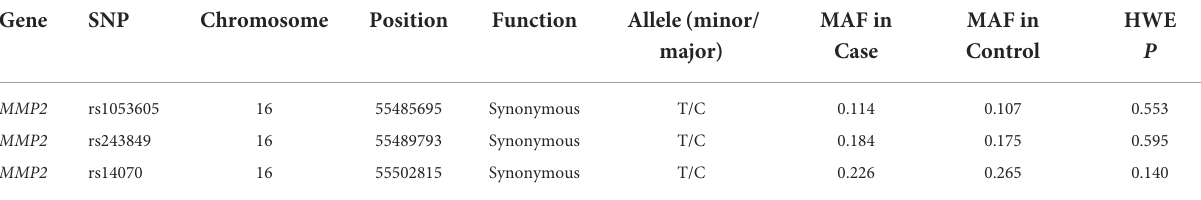
TABLE 2 Basic information of SNPs in MMP2 gene.